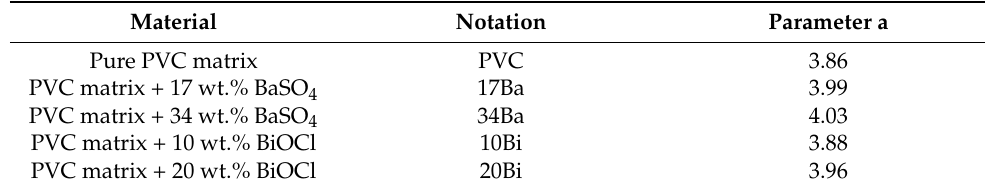
Table 2. The values of an additive constant as for the individual composites and pure PVC matrix. Material Notation Parameter a